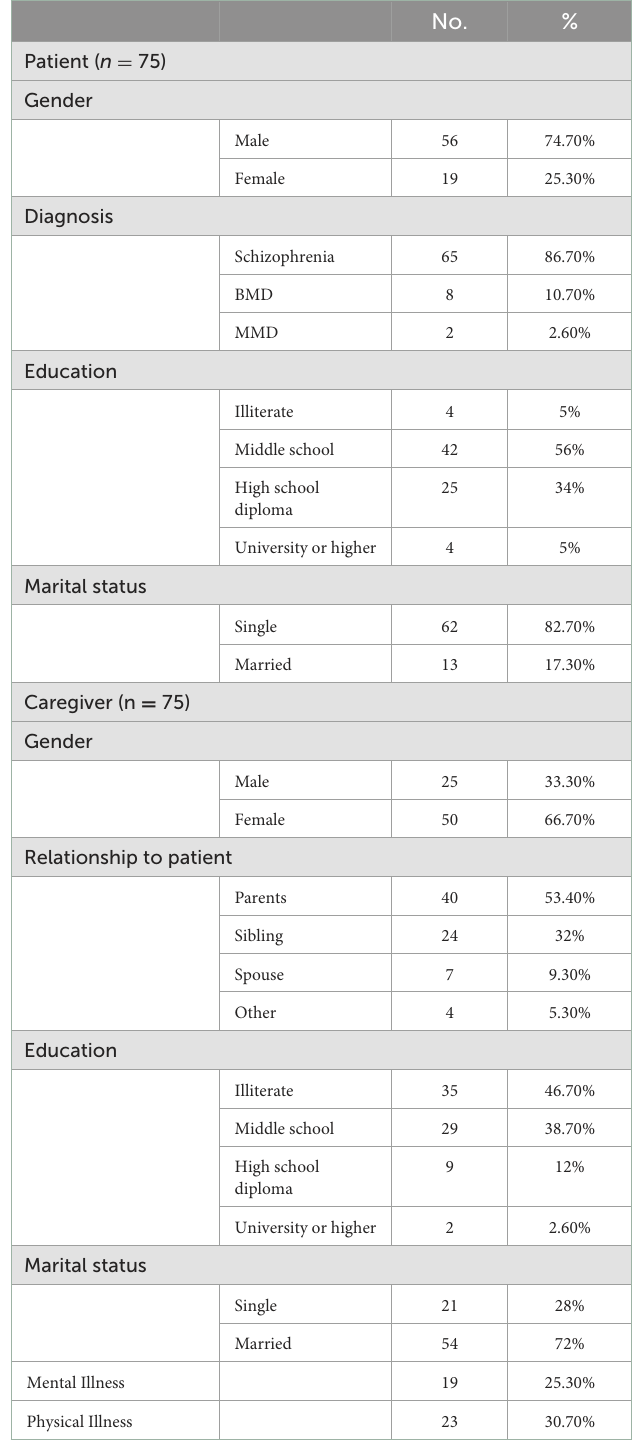
TABLE 1 Sociodemographic characteristics of participants (patients and their caregivers).